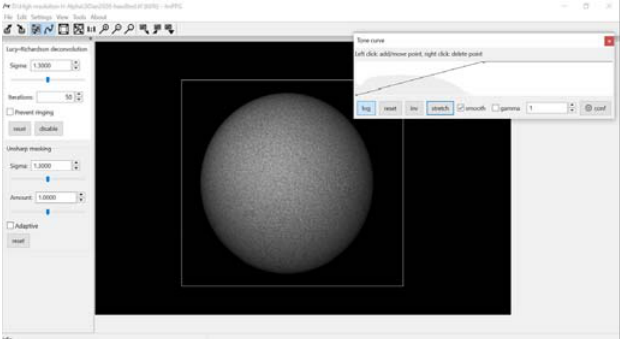
Figure 10. Stretching a tone curve in